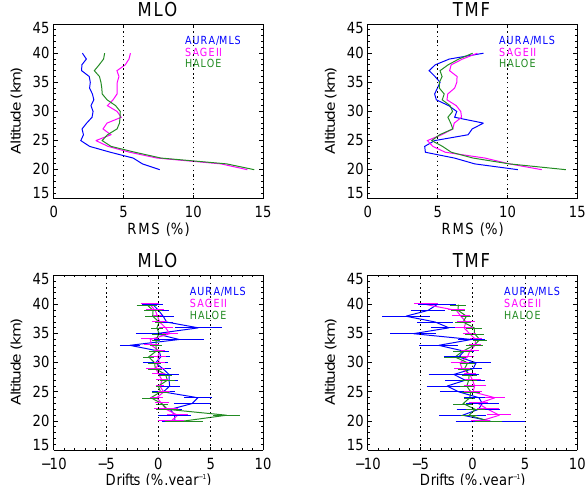
Fig. 1. Left: number of profiles by month for MLO (top) and TMF (bottom) from 1995 to 2012. Right: ozone anomalies time series (li- dar in red, merged satellite time series in black) for MLO (top) and TMF (bottom). The ozone perturbation scale is 10%km − 1 . The numbers on the right of each altitude bin denote the correlation co- efficient between the red and black curves.